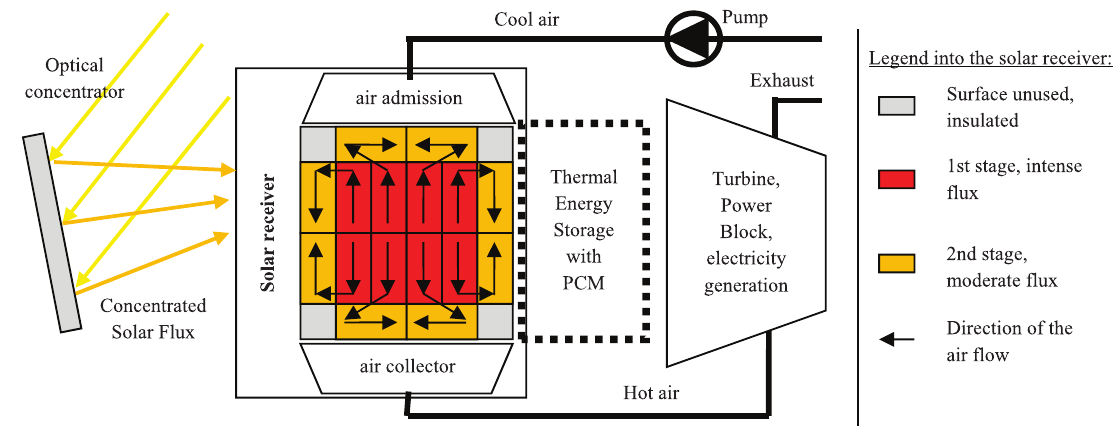
Fig. 1: Drawing of the TES coupled to the Pegase solar receiver and solar plant synopsis with pressurized air flow [18]